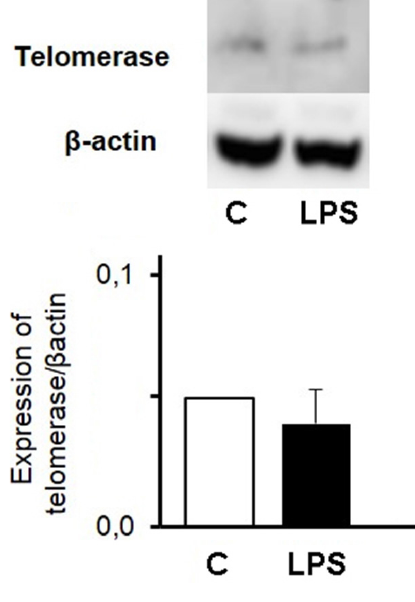
Figure 5. Telomerase expression is unaf- fected in mice subjected to endotoxemia. Expression of telomerase in kidney homog- enates from mice 1 h after LPS (15 mg/kg) injection. Data show mean ± SEM of 6–8 animals per